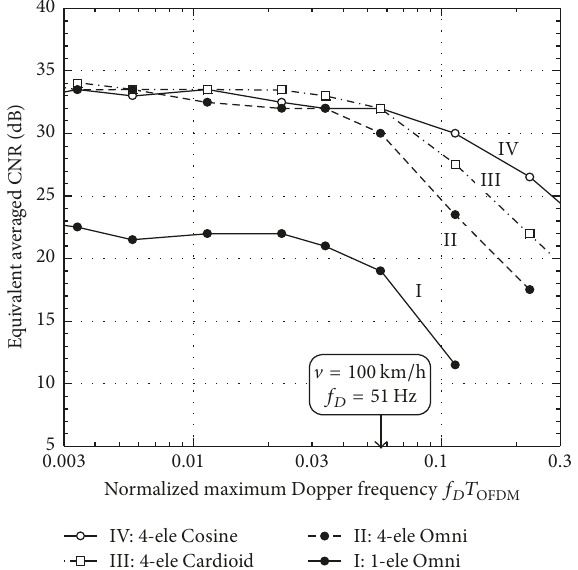
Figure 14: Fast fading tolerance for TV signal MRC reception performance in various antenna configurations.